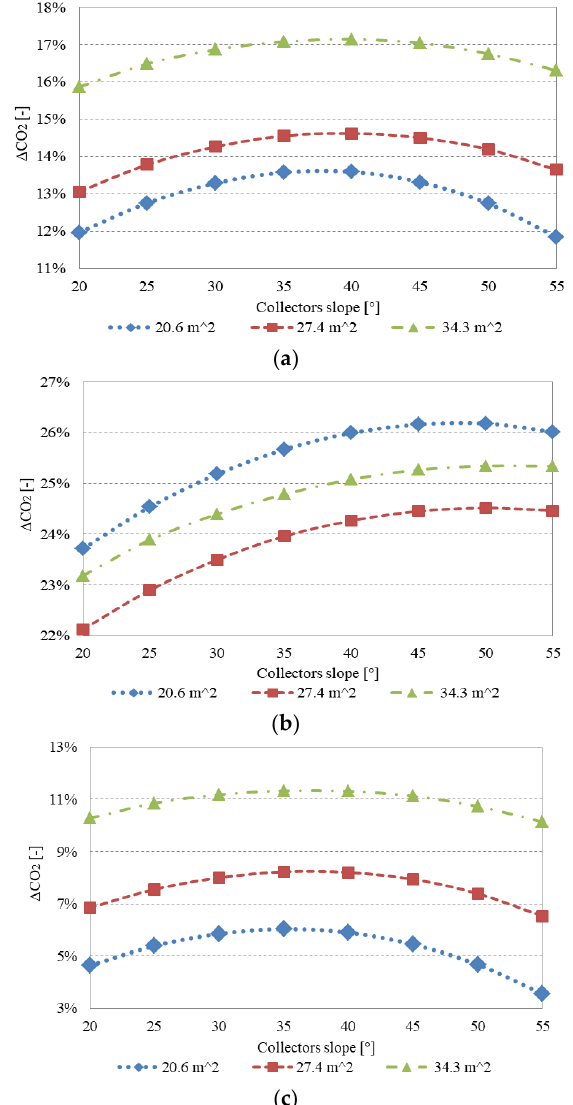
Figure 7. Equivalent CO 2 emissions avoided as a function of the tilt angle and the solar field aperture area for: ( a ) silica-gel DW, ( b ) MILGO DW and ( c ) zeolite-rich tuff DW.